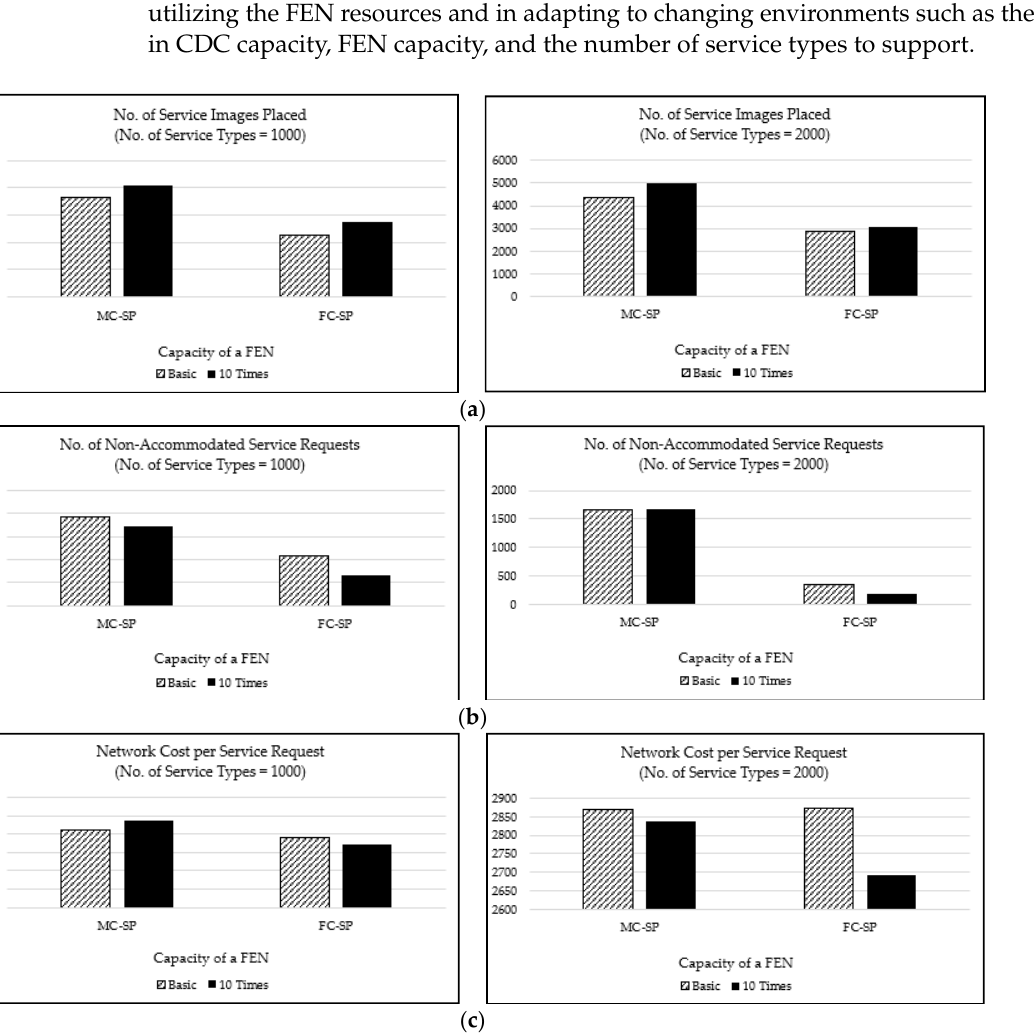
Figure 11. The performance according to the FEN capacity and the number of service types for the L distribution case: ( a ) the number of service images placed; ( b ) the number of non-accommodated service requests; and ( c ) the network cost per service request.